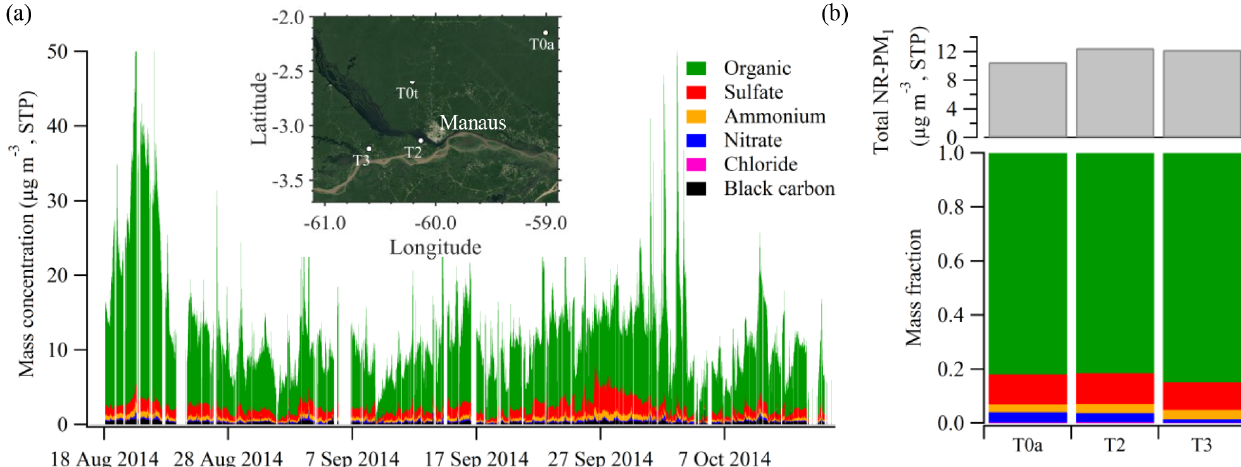
Figure 1. PM 1 composition during the dry season from 15 August to 15 October 2014, representing the second Intensive Operating Period (IOP2) of the GoAmazon2014/5 experiment. Results are shown for measurements at T3 in comparison to other sites. (a) PM 1 mass concen- trations of non-refractory AMS organic, sulfate, ammonium, nitrate, and chloride. Mass concentrations of SP2 refractory black carbon (rBC) are also plotted. rBC refers to the carbon content of graphite-like components that are strongly light absorbing (Pöschl, 2003). (b) Summed mass concentrations (top) and segregated mass fractions (bottom) of the non-refractory species at the T0a, T2, and T3 sites. The inset of panel (a) shows the locations of the relevant research sites for this study. A larger map is shown in Fig. 3. T0a is the Amazon Tall Tower Observatory (Andreae et al., 2015). T2 is a site 8km downwind of Manaus, just across the Black River (“Rio Negro”) (Cirino et al., 2018). Measurements at T0a and T2 were made by an aerosol chemical speciation monitor (ACSM). Concentrations in both panels were adjusted to standard temperature (273.15K) and pressure (10 5 Pa)